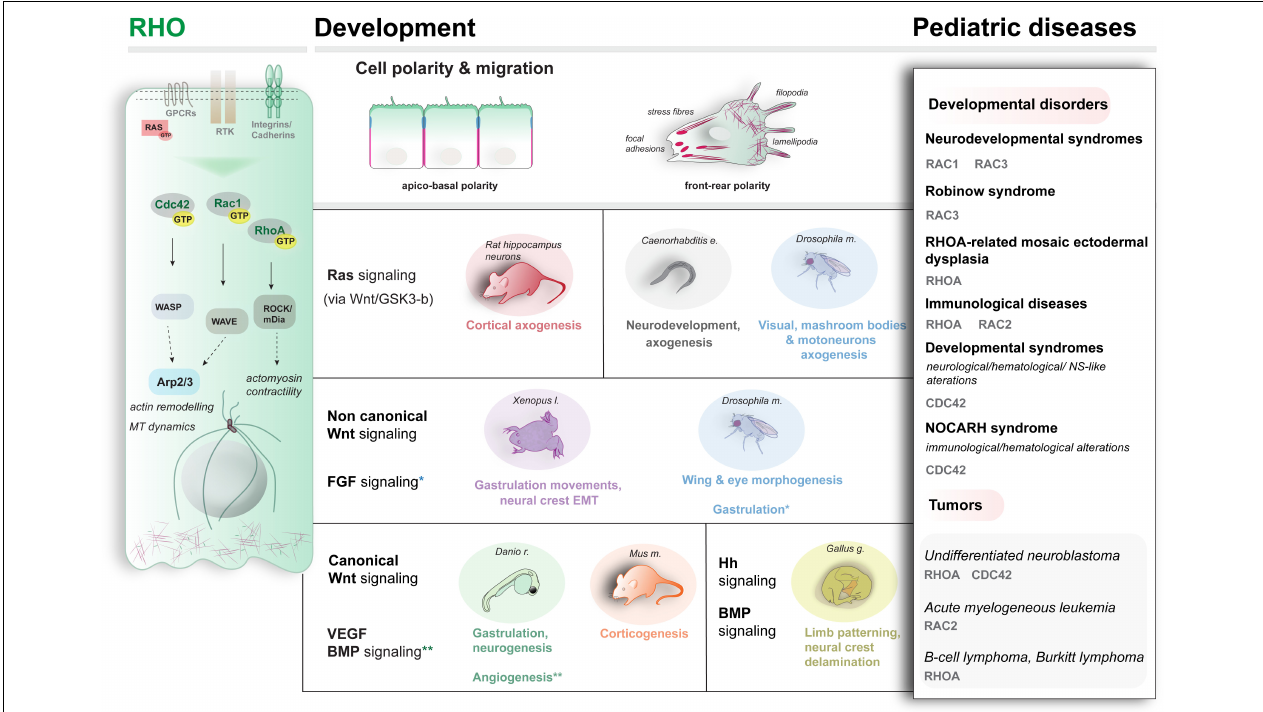
FIGURE 2 | Schematic representation of the main RHO proteins’ activity (left), examples of the developmental pathways and processes modulated by RHO (center) and examples of genetic conditions associated with altered Rho activity (right).